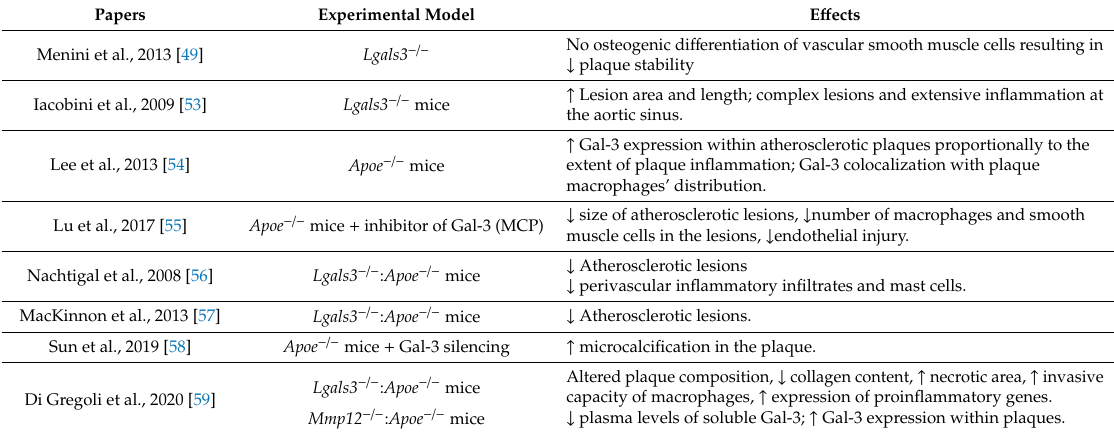
Table 1. Main in vivo studies on the direct role of Gal-3 in the atherosclerotic